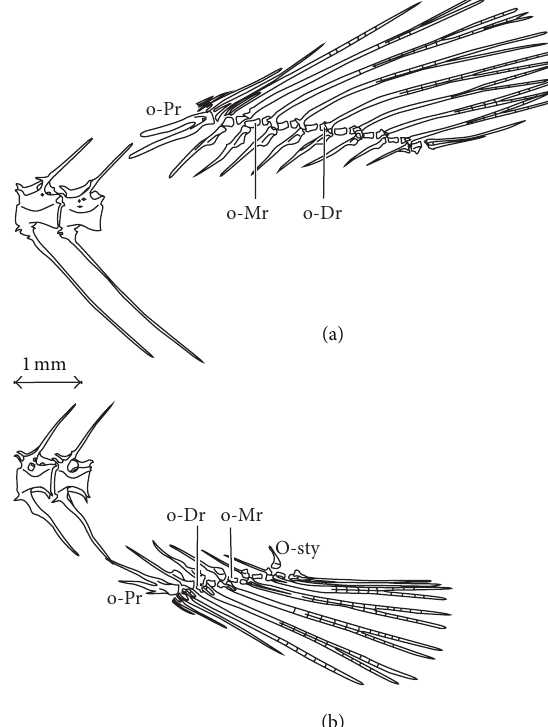
chomanicus . dr: distal radial; mr: medial radial; pr: proximal radial; sty: stay.